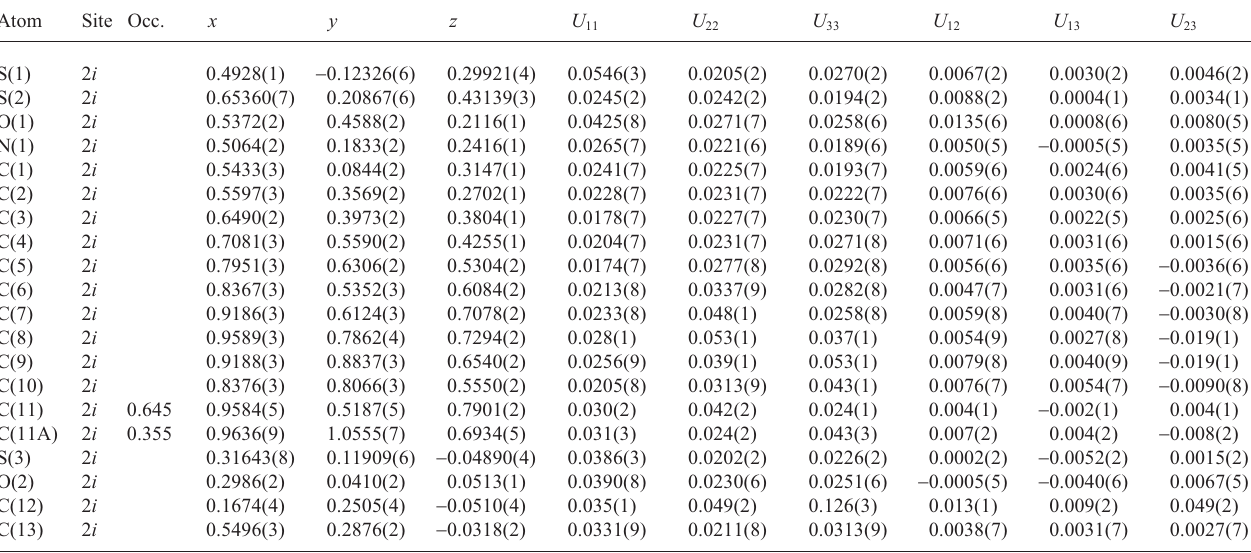
Table 3. Atomic coordinates and displacement parameters (in Å 2 ) . Atom Site